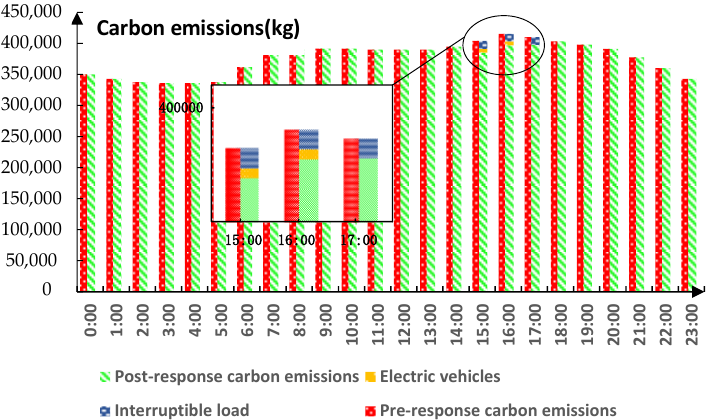
Figure 8. Carbon emissions before and after response.